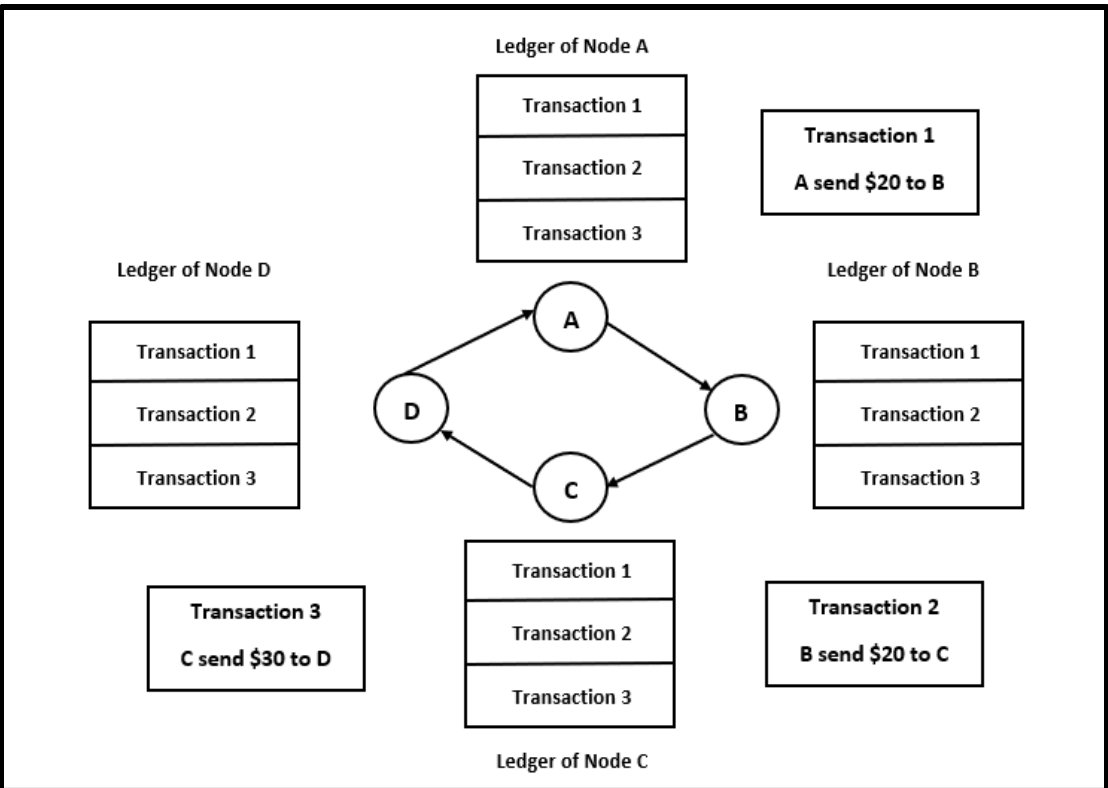
Figure 2. Blockchain Technology